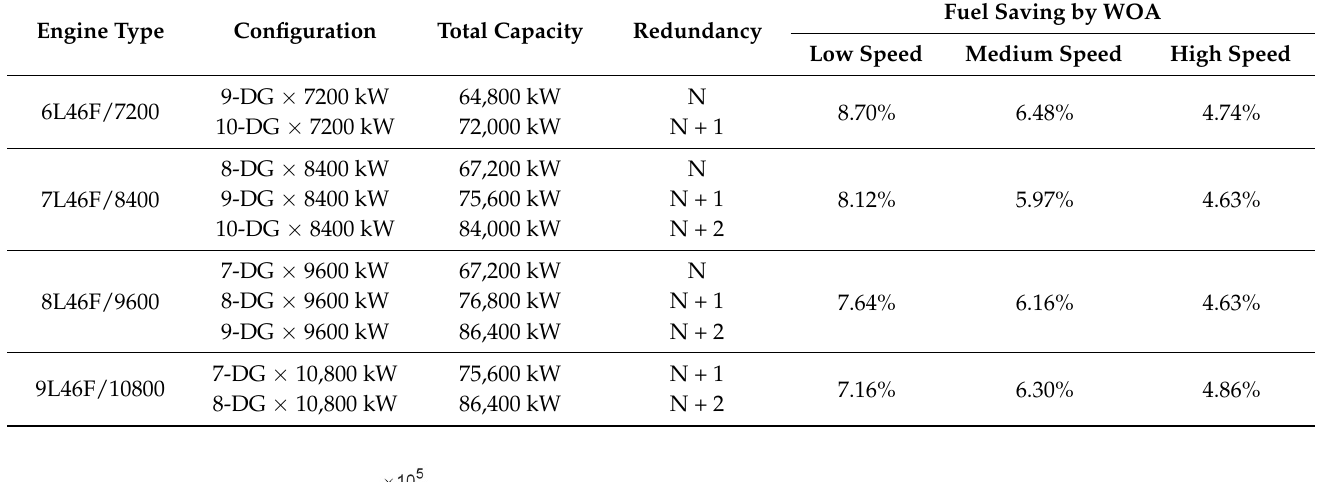
Table 6. Non-conventional system designs with average fuel-saving results.